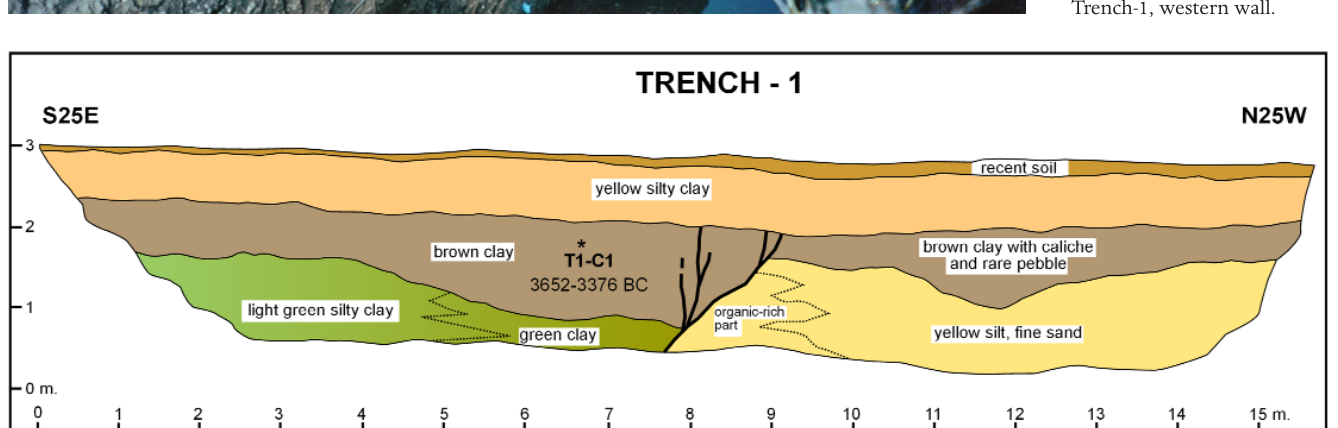
Figure 7 (below). Log of Trench-1, western